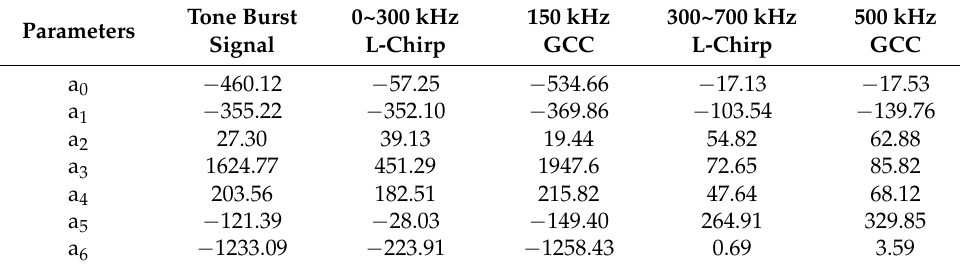
Table 2. The model parameters of 300~700 kHz L-Chirp and 500 kHz